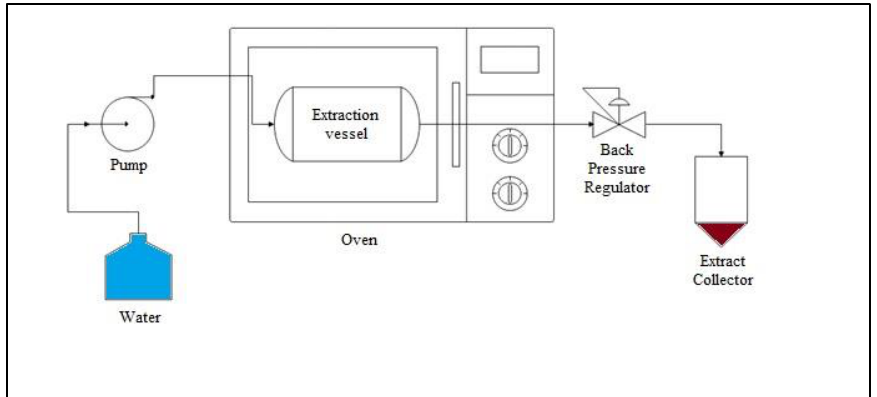
Figure 1. The subcritical water extraction (SWE) scheme. Table 1. The parameters and responses of subcritical water extraction (SWE).